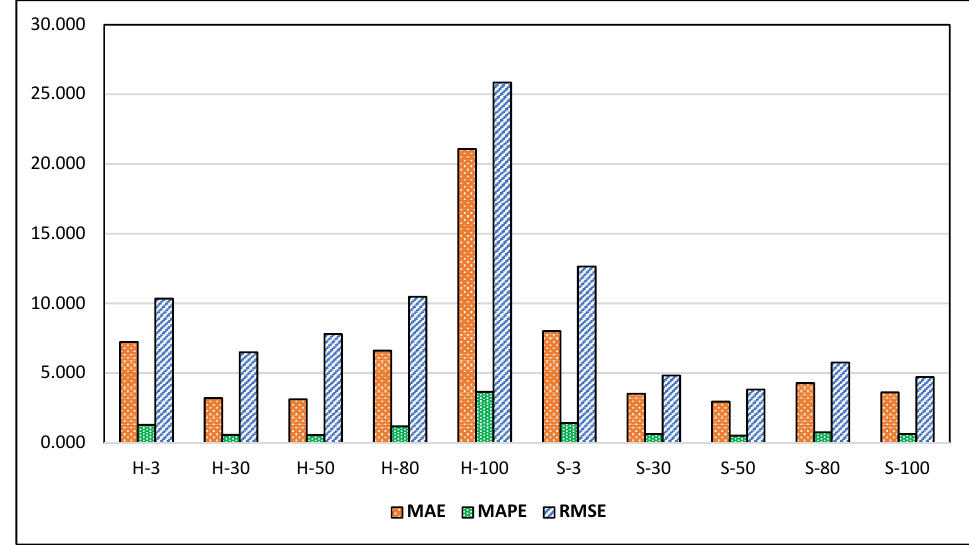
Figure 5. Comparison of the errors for various models.